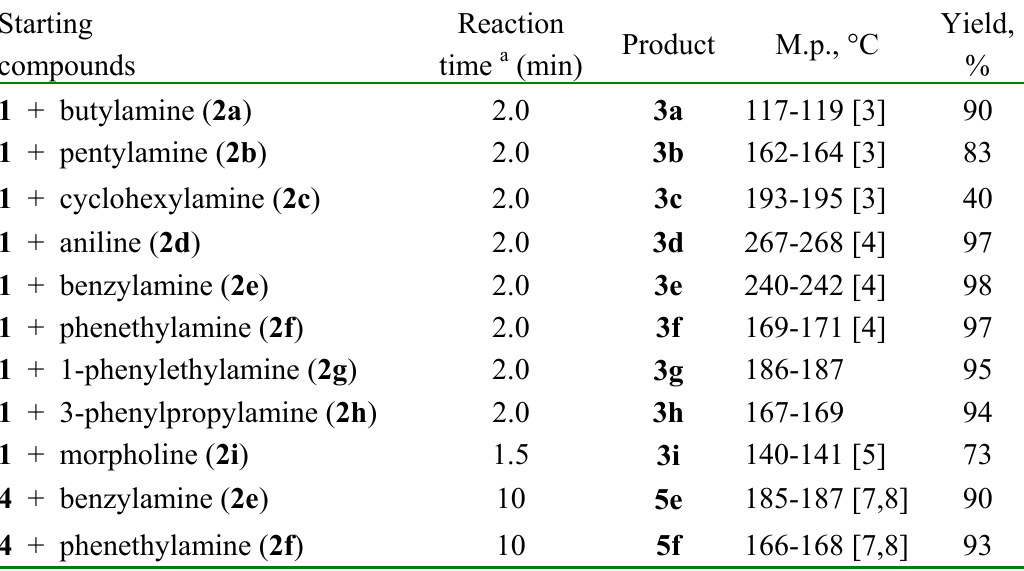
Table 1. 4-(Alkylamino)coumarins ( 3a-c , e-h ), 4-(Phenylamino)coumarin ( 3d ), 4-Morpholinocoumarin ( 3i ), and N,N'